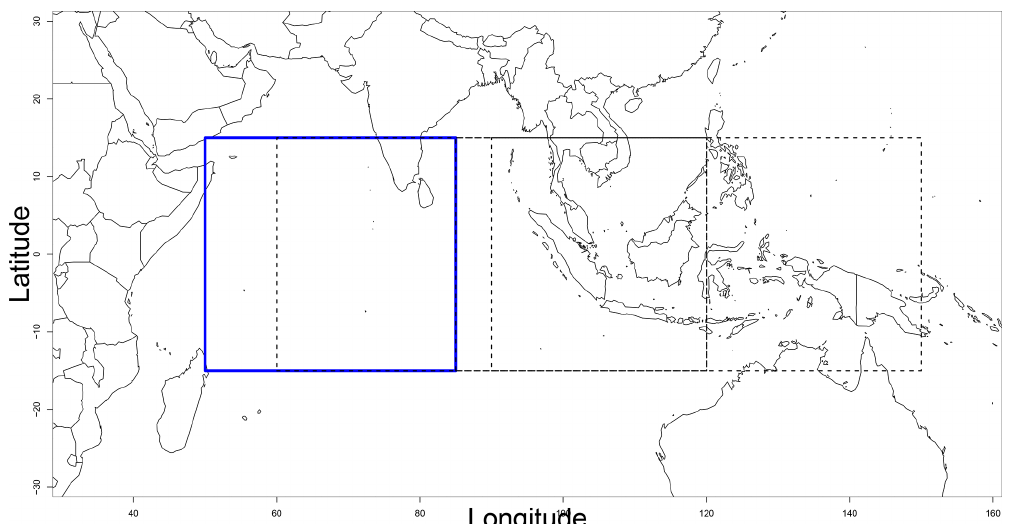
Figure B1. Domains of computation of analogs. We computed analogs over the Indian Ocean with coordinates 15 ◦ S–15 ◦ N, 50–85 ◦ E (blue rectangle); the Indian and Pacific oceans with coordinates 15 ◦ S–15 ◦ N, 85–120 ◦ E; and the Indian Ocean–Maritime Continent region with coordinates 15 ◦ S–15 ◦ N, 90–150 ◦ E.